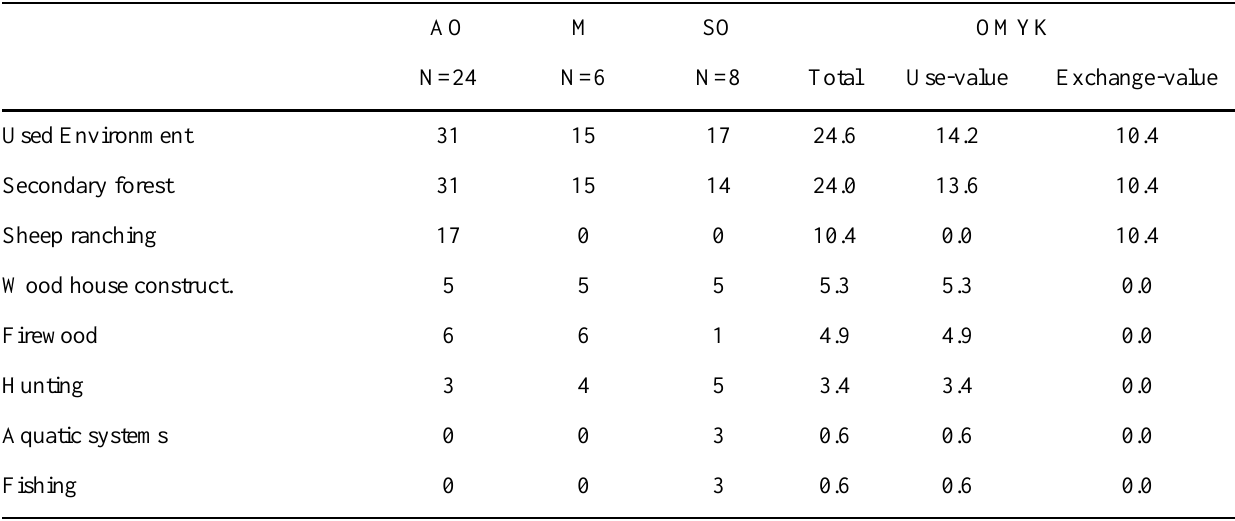
Table 4. Activities and average annual labor allocation by households’ productive strategy and OMYK as a whole in the Used Environment (UET). Numbers are per household and based on an 8-hour work day. AO M SO OMYK N=24 N=6 N=8 Total Use-value